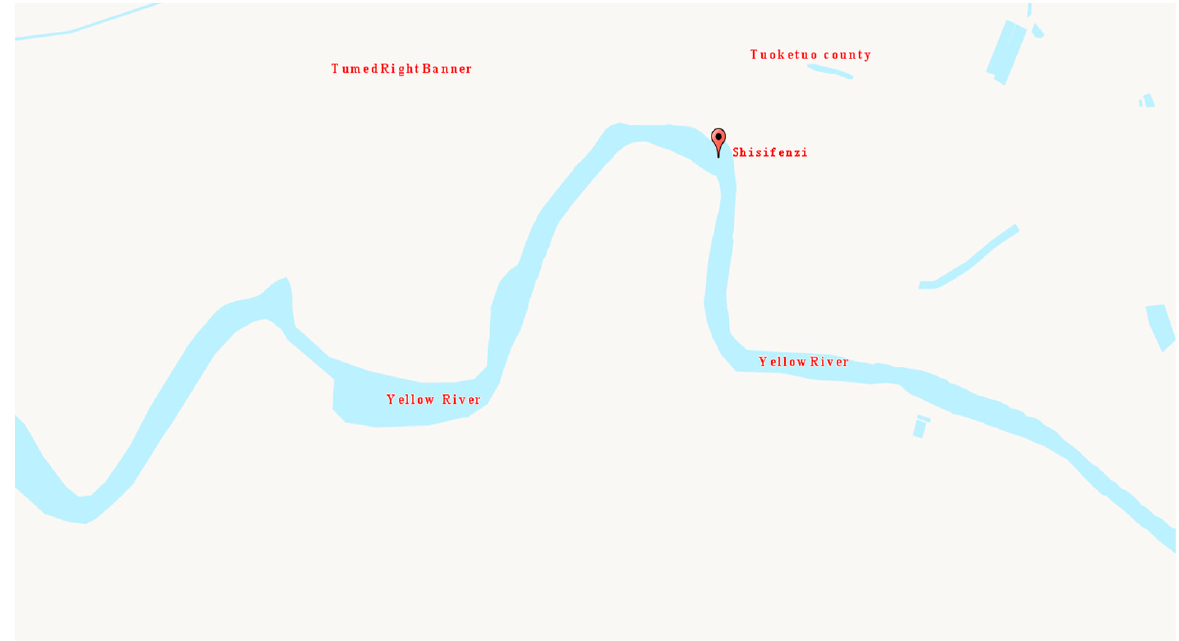
Figure 2. Specific location of equipment installation.